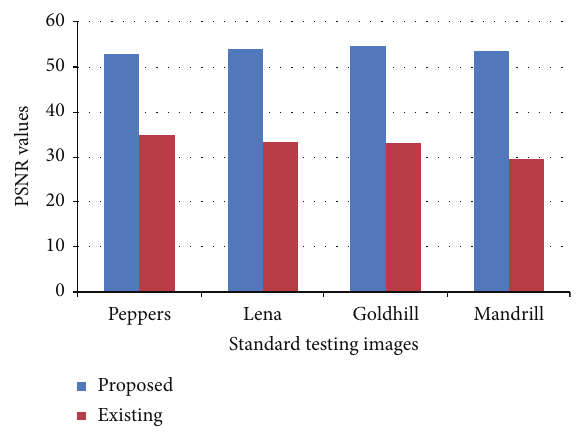
Figure 5: PSNR analysis on different standard testing images. throughput easily meets the real time encoding require-